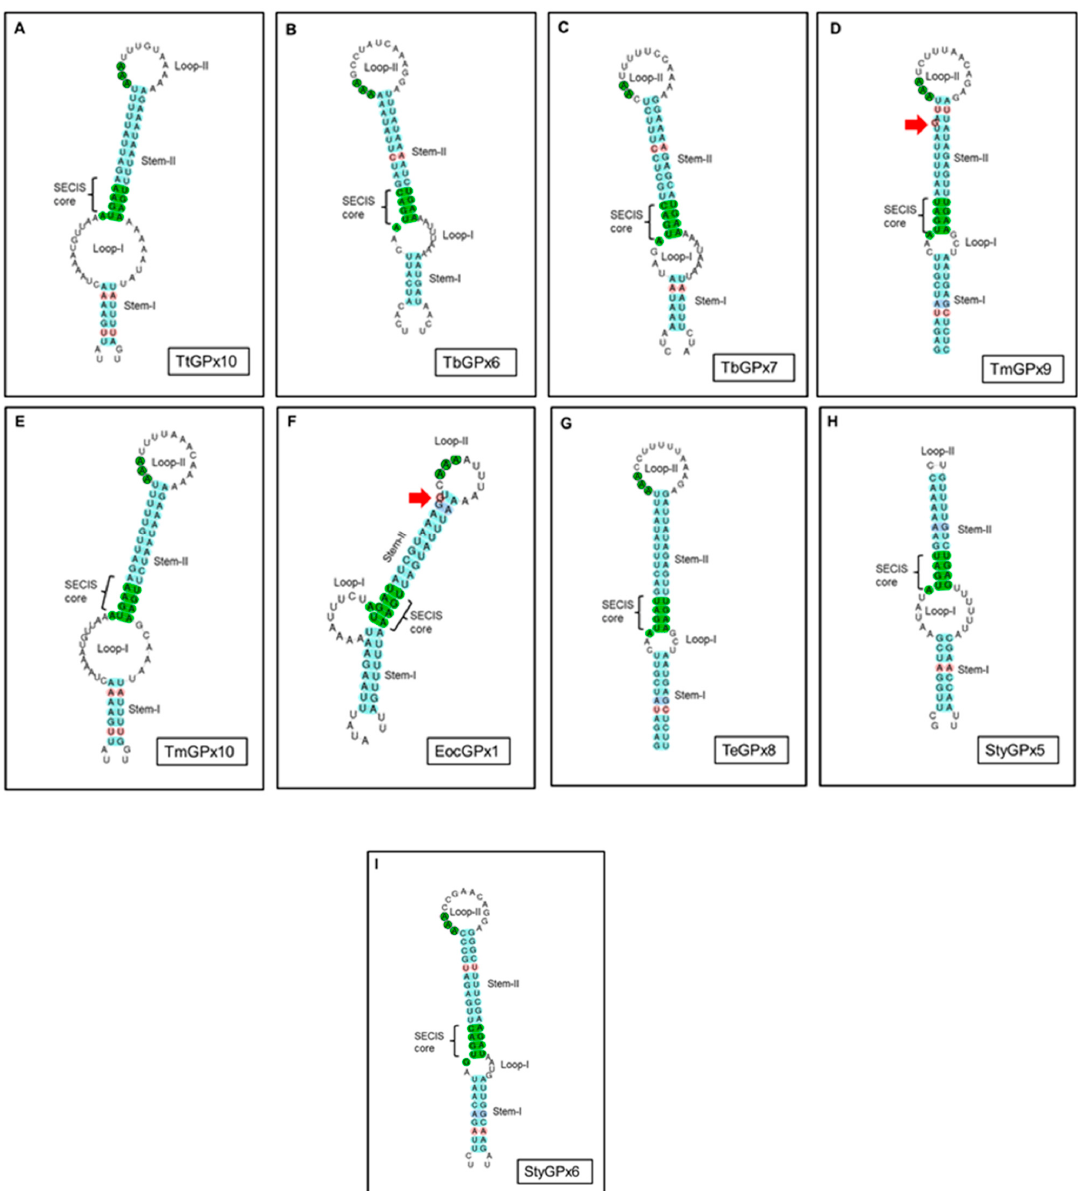
Figure 1. Secondary structures of the predicted selenocysteine insertion sequence (SECIS) elements of nine ciliate GPx ( A – I ). Canonical SECIS core and triplet of conserved adenines in loop-II are shaded in green. Stem-I and II are shaded in blue. Mismatched bases are shaded in red and / or indicated by a red arrow. Non-canonical base pairings (AG / GA) are shaded in purple. See Table 1 for species names. Ten of the twelve putative TtGPx (TtGPx1, 2, 4, 5, 6, 7, 8, 9, 11 and 12) have been identified as phospholipid hydroperoxide glutathione peroxidases (PHGPx) by the Tetrahymena genome comparative database. However, after using standard protein BLAST, nine of them showed their highest identity values (48–55%, and a query cover (QC) between 76 and 97%) to classical GPx from other organisms (mainly, the urochordate marine animal Ciona intestinalis ). From them, only TtGPx1 has a 48.8% − 51 identity (QC = 95%, E (expected frequency value) = 1e ) with the PHGPx6 of the angiosperm plant Pyrus ussuriensis